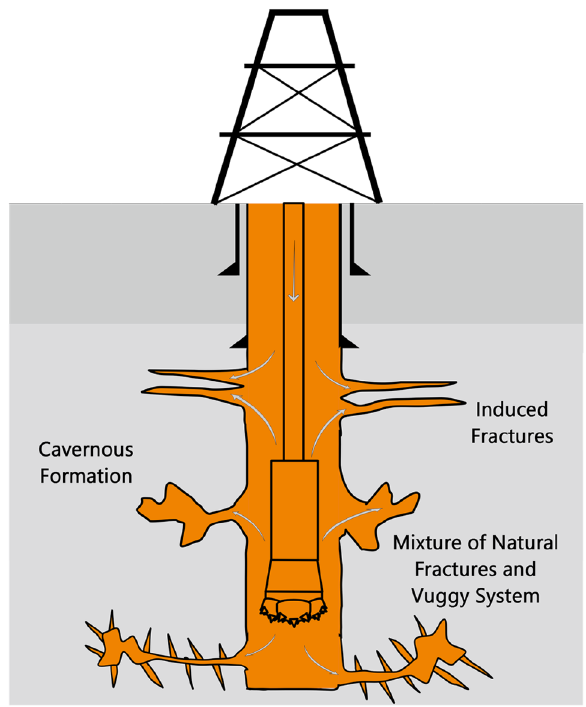
Fig. 1 Different subsurface systems encounter loss circulation of drilling